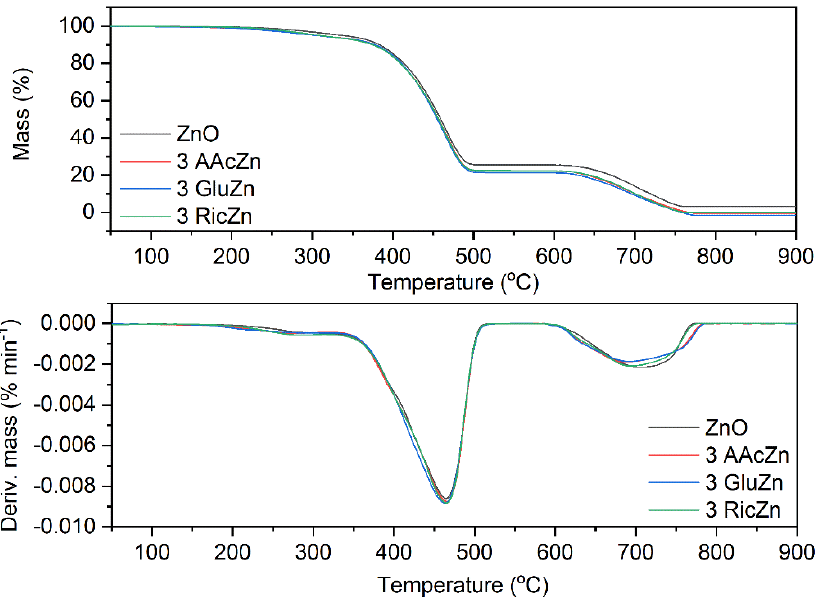
Figure 8. Thermogravimetric (TG) and differential thermogravimetric (DTG) curves of SBR vulcanizates with 3 phr of varying activators.